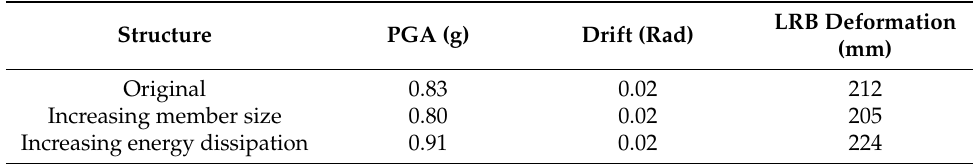
Table 4. Comparison of the different